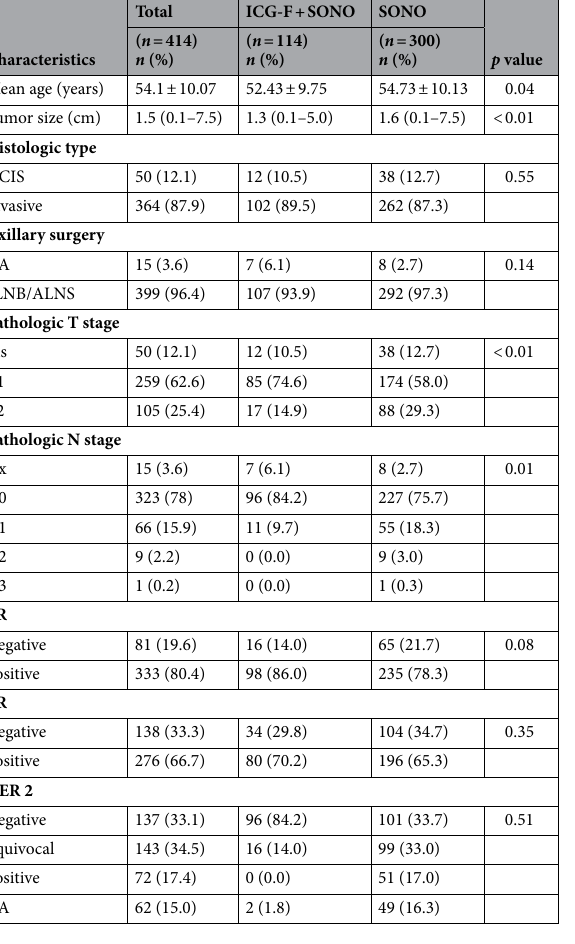
Table 1. Baseline characteristics of the study population. ICG-F indocyanine green fluorescence, SONO sonography, DCIS ductal carcinoma in situ, NA not access, SLNB sentinel lymph node biopsy, ALNS axillary lymph node sampling, T tumor, N nodal, ER estrogen receptor, PR progesterone receptor, HER2 human epidermal growth factor receptor